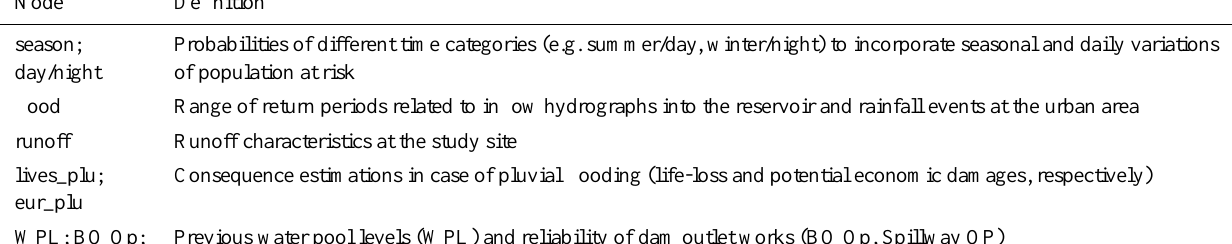
Table 3. Nodes for Risk Model